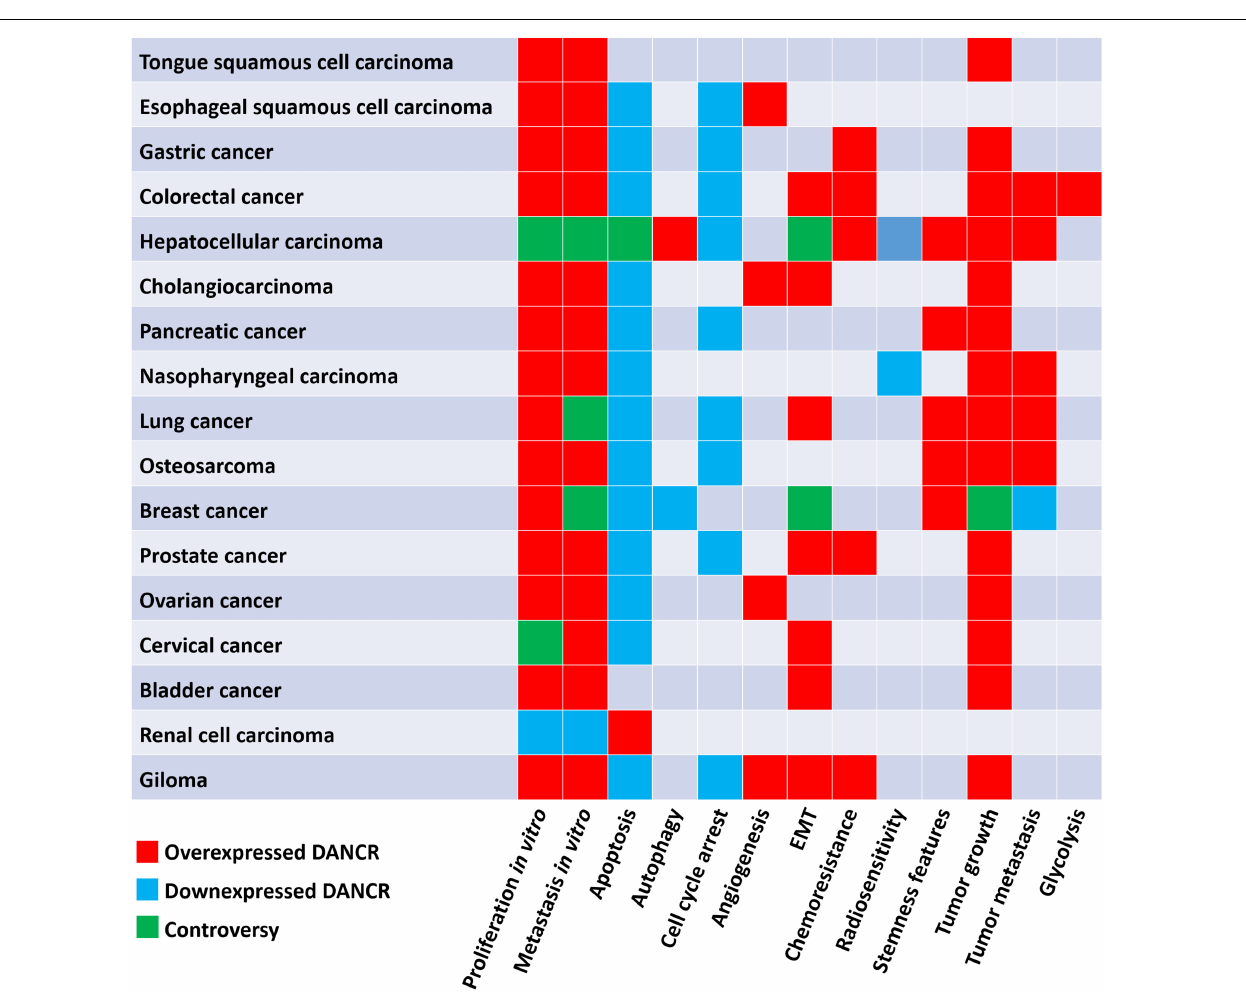
FIGURE 2 | The biological function of DANCR in different